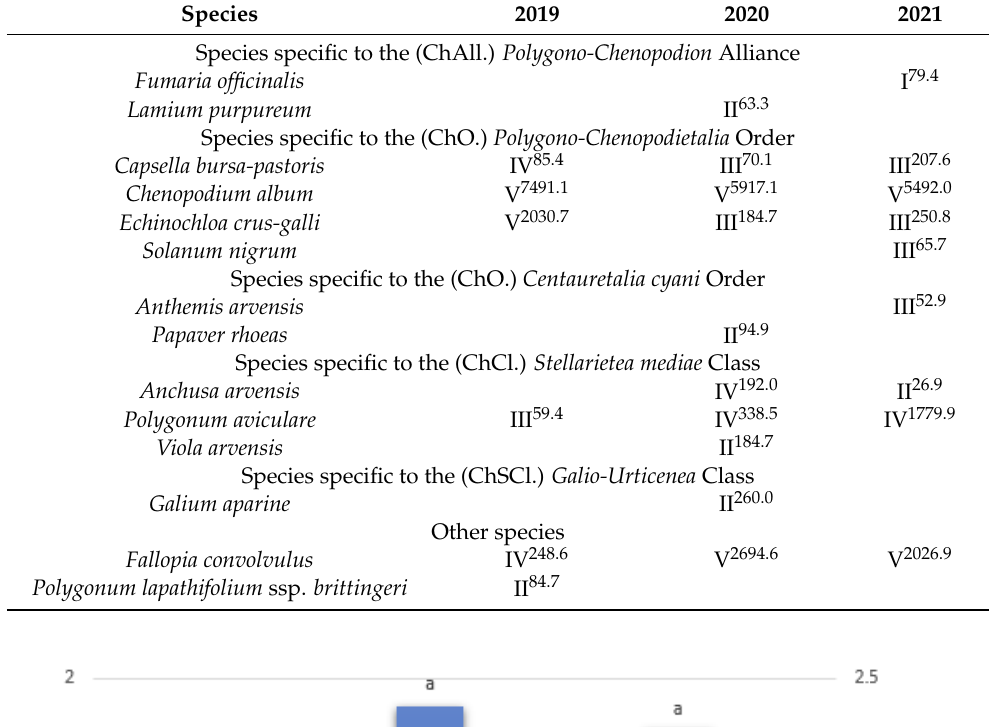
Table 4. Constancy degrees (Braun − Blanquet approach) and cover coefficient values of species in maize.